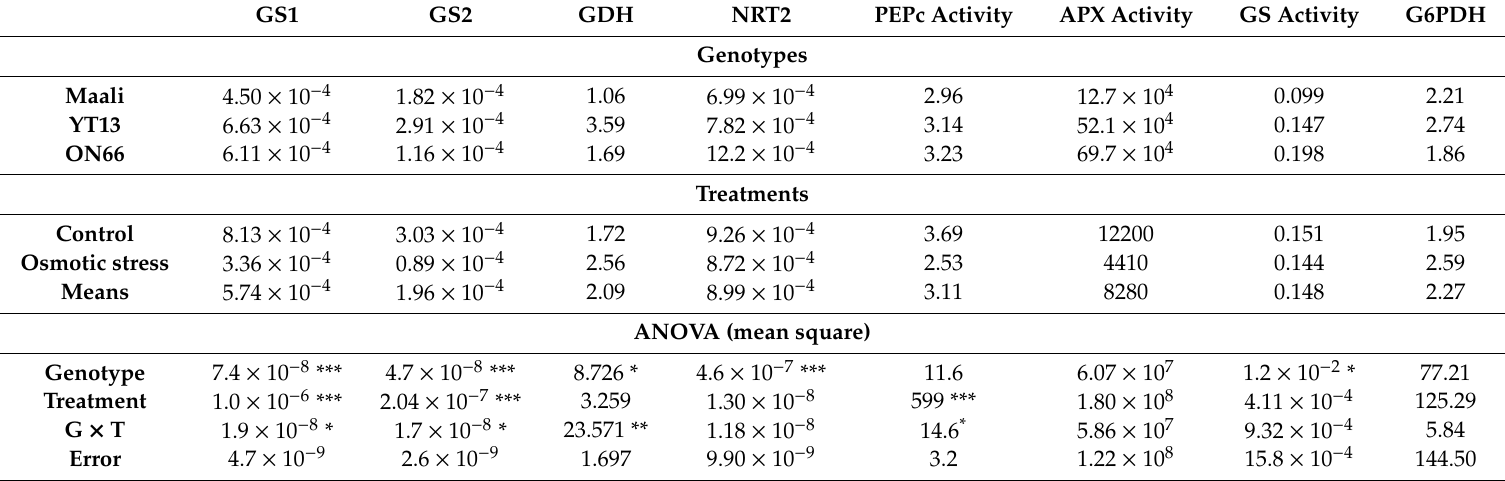
Table 2. Genotype and treatment e ff ects on genes expression (GS1, GS2, GDH, and NRT2) and enzymes activities (PEPC, APX, GS, and G6PDH) of three durum wheat genotypes grown under osmotic stress. In the lower panel, the ANOVA analysis is given. Legend: G, genotype; T, Treatment, *, **, *** significant at p < 0.05, p < 0.01 and p < 0.001